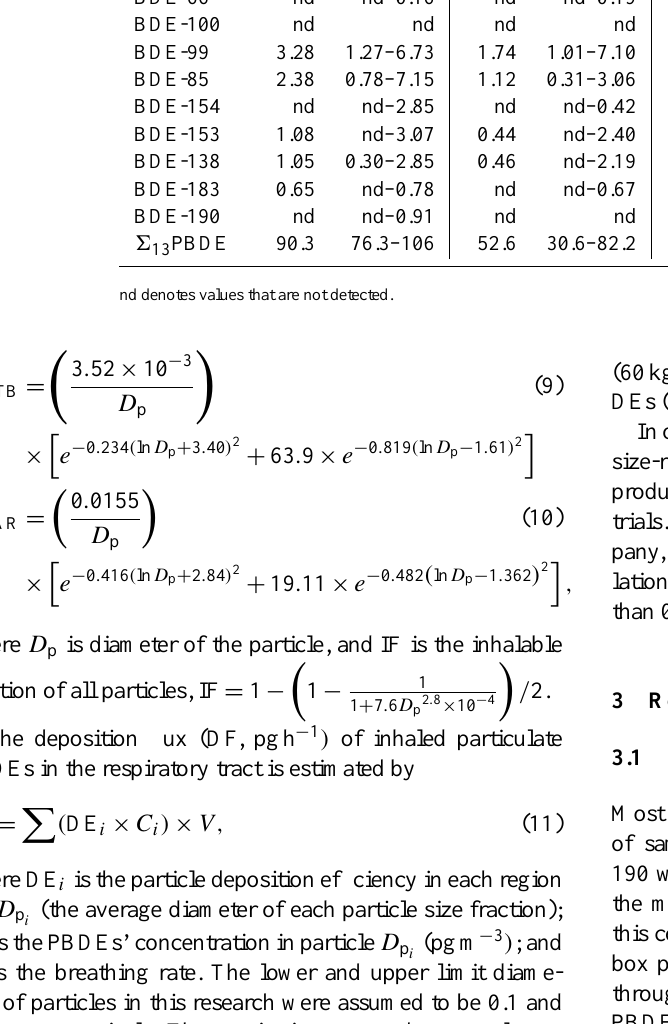
whereas the top and bottom end of the box represent the 75th and 25th percentiles of the data set, respectively. The exten- sions (whiskers) at either end of the box indicate the 95th and 5th percentile, and the solid spheres represent the max- imum and minimum values. The median concentrations are indicated by the solid vertical lines, whereas the mean con- centrations are depicted by the horizontal line. In general, the size of the box and the length of the whiskers are an in- dicator of the variability in concentrations at a given site for a given compound containing the same number of